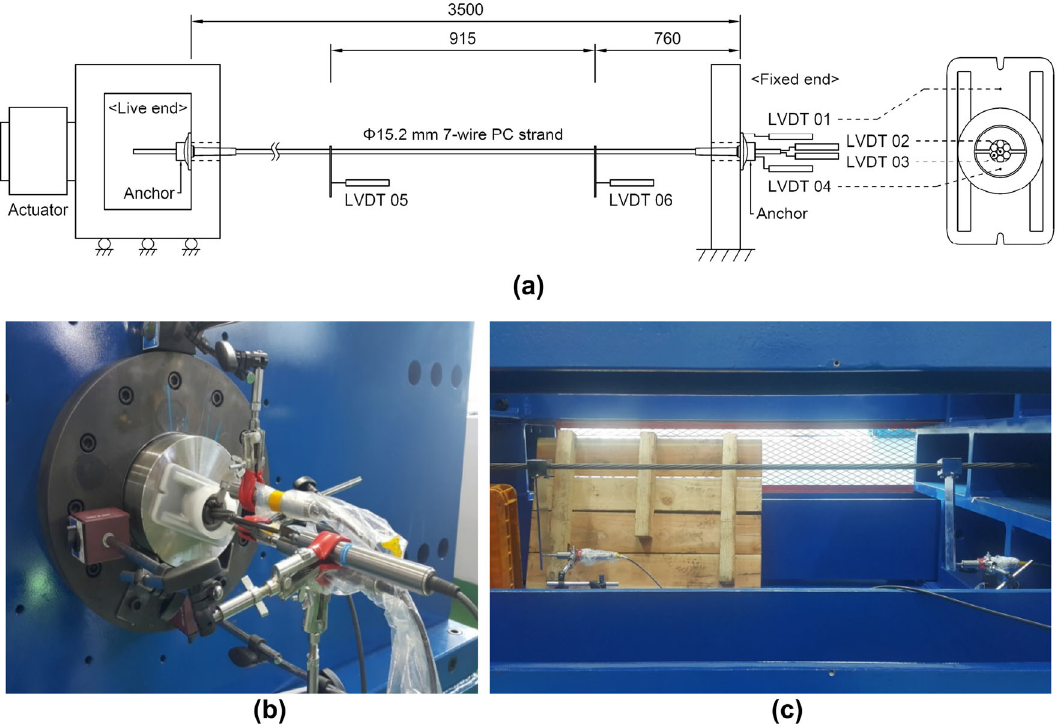
Fig. 2 Setup of static load test. a Section view (unit: mm), b fixed end, and c middle of free length.